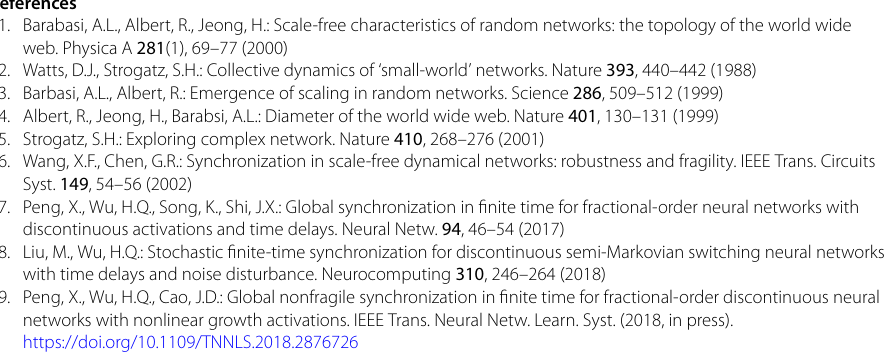
and time-varying delays. A novel integral sliding-mode controller was proposed. On the basis of Lyapunov stability theory, it has been shown that the Markovian jump complex dynamical network systems via sliding-mode control can be guaranteed to show synchro- nization and satisfy H ∞ performance. An example was given to shown the effectiveness of the obtained